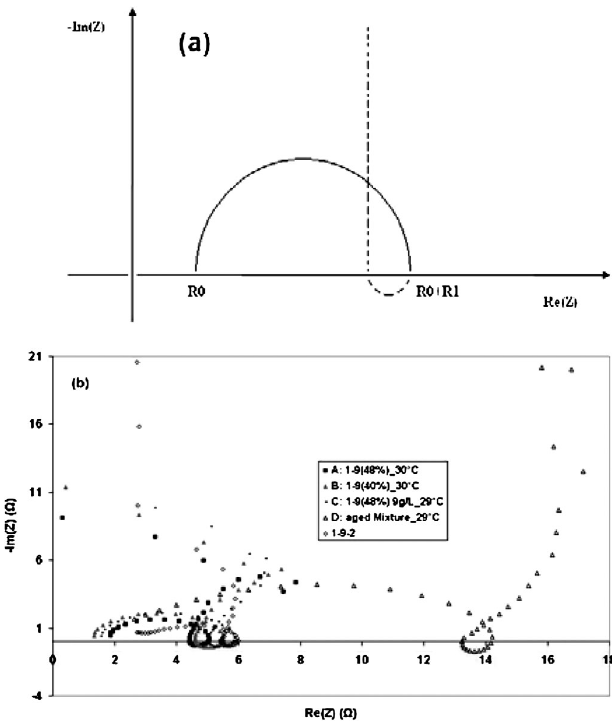
mixtures.FIG. 5. (a) General shape at high frequencies of Nyquist dia- grams (top) and (b) spectra obtained at 4.5 V vs Ref range 100 kHz and 0.1 Hz